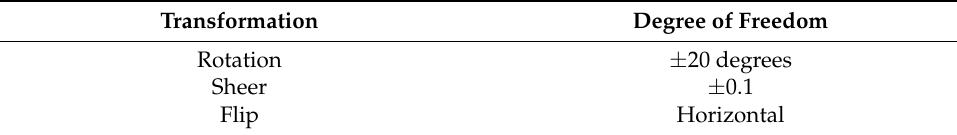
Table 2. Data augmentation